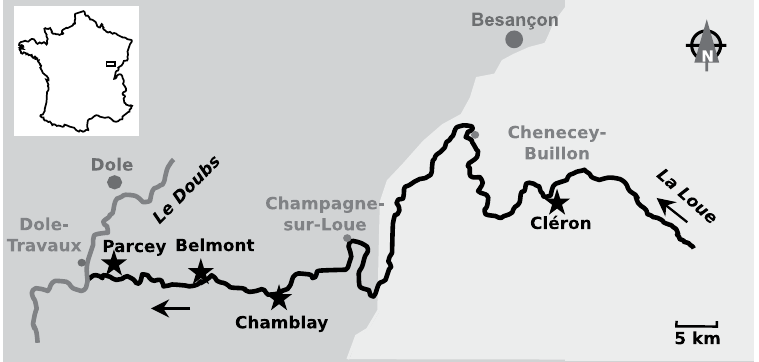
Figure 1. Geographic locations of the sampling sites (represented by stars) in the Loue River. Arrows represent flow direction. Lighter zones represent altitudes more than 300 meters above sea level. This figure was drawn by the authors using Inkscape 0.91